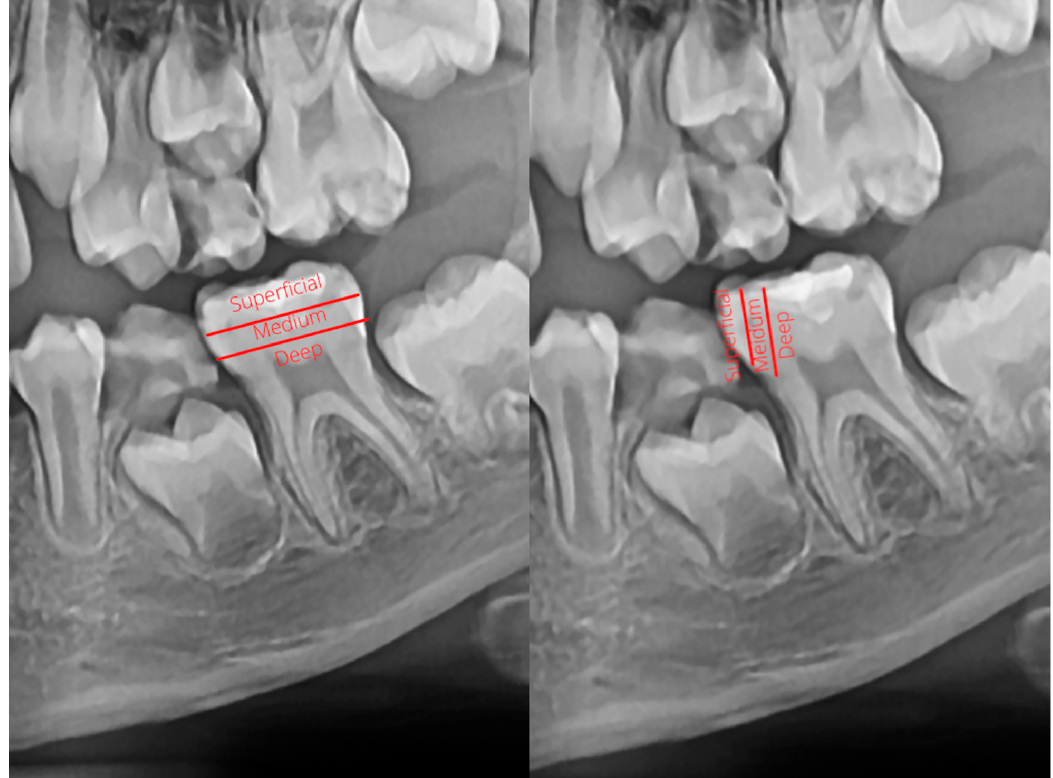
Figure 2. Classification of dental caries according to their depth.